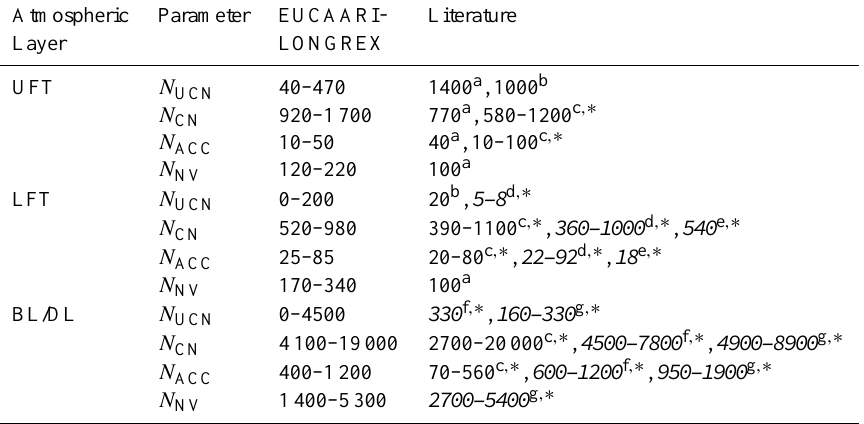
Table 5. Comparison of number concentrations observed during the EUCAARI-LONGREX field campaign with number concentrations reported in literature. All number concentrations are reported in cm − 3 stp. Italic characters indicate ground based measurements, airborne measurements are indicated with non-italic